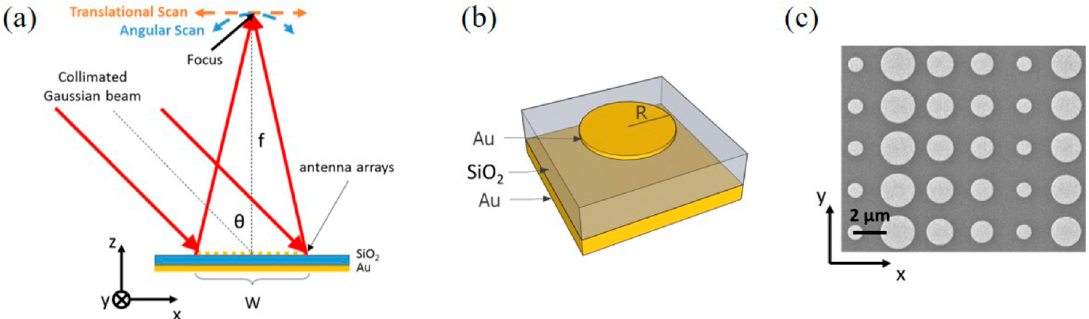
Figure 12. ( a ) Schematic illustration of a flat metalens using MIM-PMAs. ( b ) Schematic illustration of the unit cell of a reflector array lens. ( c ) SEM image of the metalens surface. Figures are adapted with permission from Reference [123]. © 2016 Optical Society of America.